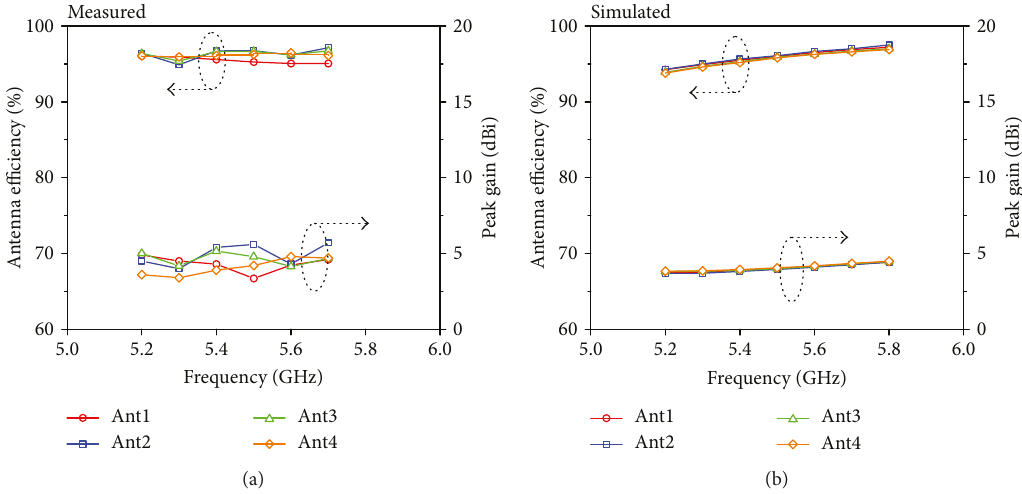
Figure 8: (a) Measured and (b) simulated antenna e ffi ciencies and peak gains of the four-element MIMO